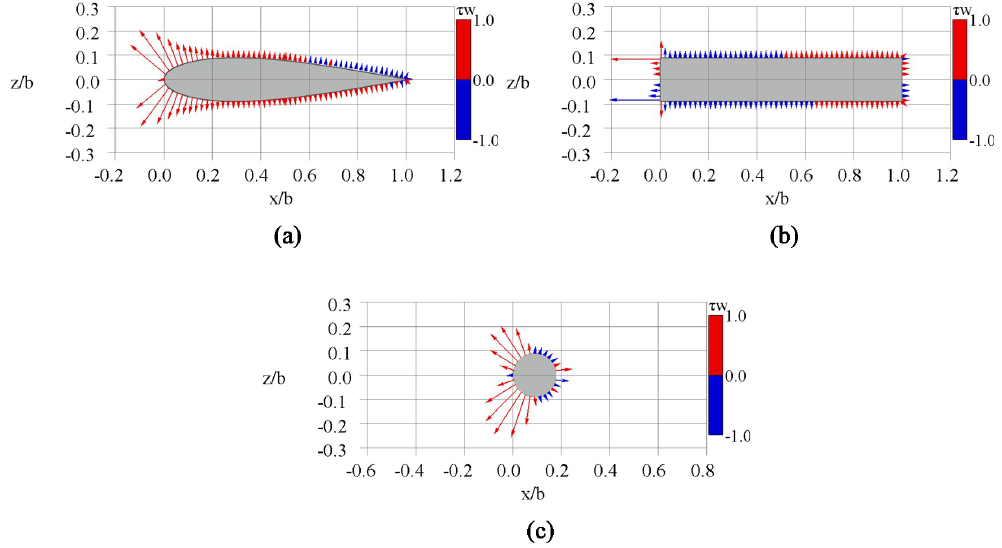
Figure 17. Wall shear stress, or surface friction, distributions on the arm cross-section of n = 30 in each rotor case with di ff erent cross-section arms: ( a ) airfoil arm rotor, ( b ) rectangular arm rotor, and ( c ) circular arm rotor. The values of the color bars showing the wall shear stress τ w have an arbitrary unit expressing only the direction of the wall shear stress.